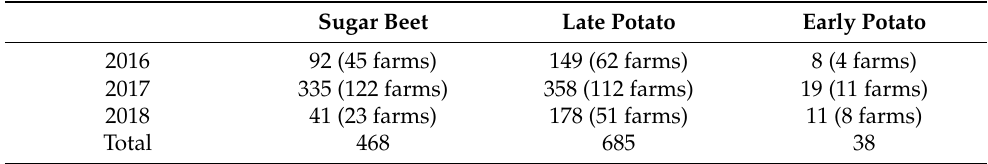
Table 1. Sugar-beet, late-potato, and early-potato fields for which aNDVI was calculated. The numbers in parentheses are the number of farms to which the fields